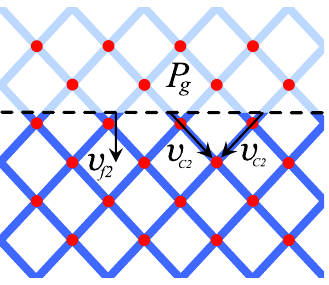
Figure 9. The network model and gas/liquid interface.